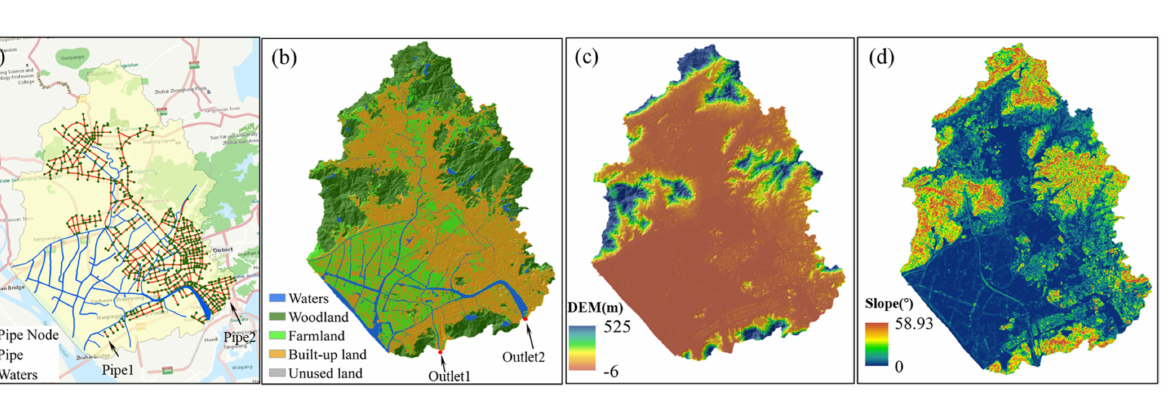
Figure 2. Relevant data in this study, where ( a ) is the pipe network, ( b ) is the land use, ( c ) is the DEM, ( d ) is the slope map, with a spatial resolution of 30 m. Pipe1 and Pipe2 in Figure ( a ) are, respectively, the selected pipes for model verification, while Outlet1 and Outlet2 in Figure ( b ) are, respectively, the selected river channel outlet for model verification. The curve numbers (CN) and manning coefficients were also key parameters for the